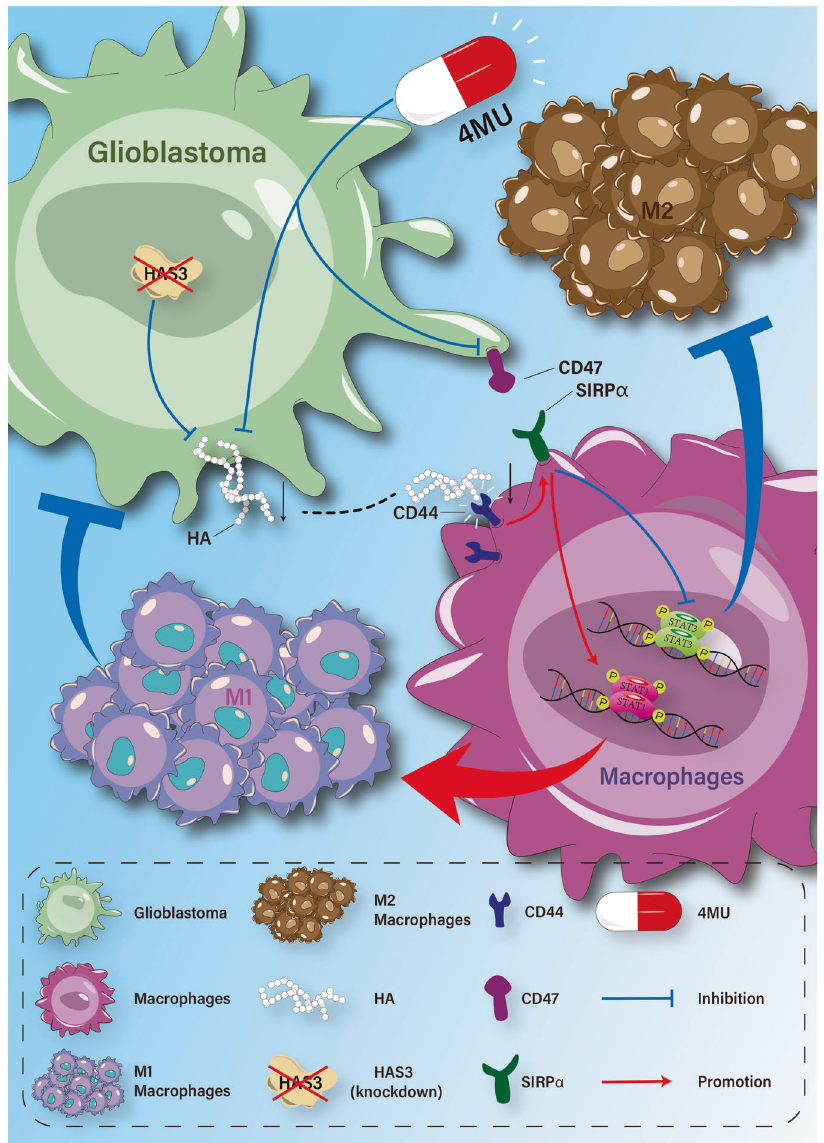
Fig. 7 Schematic illustration of the communication between glioblastoma cells and macrophages with disruption of HA pathway in glioblastoma and macrophages coculture